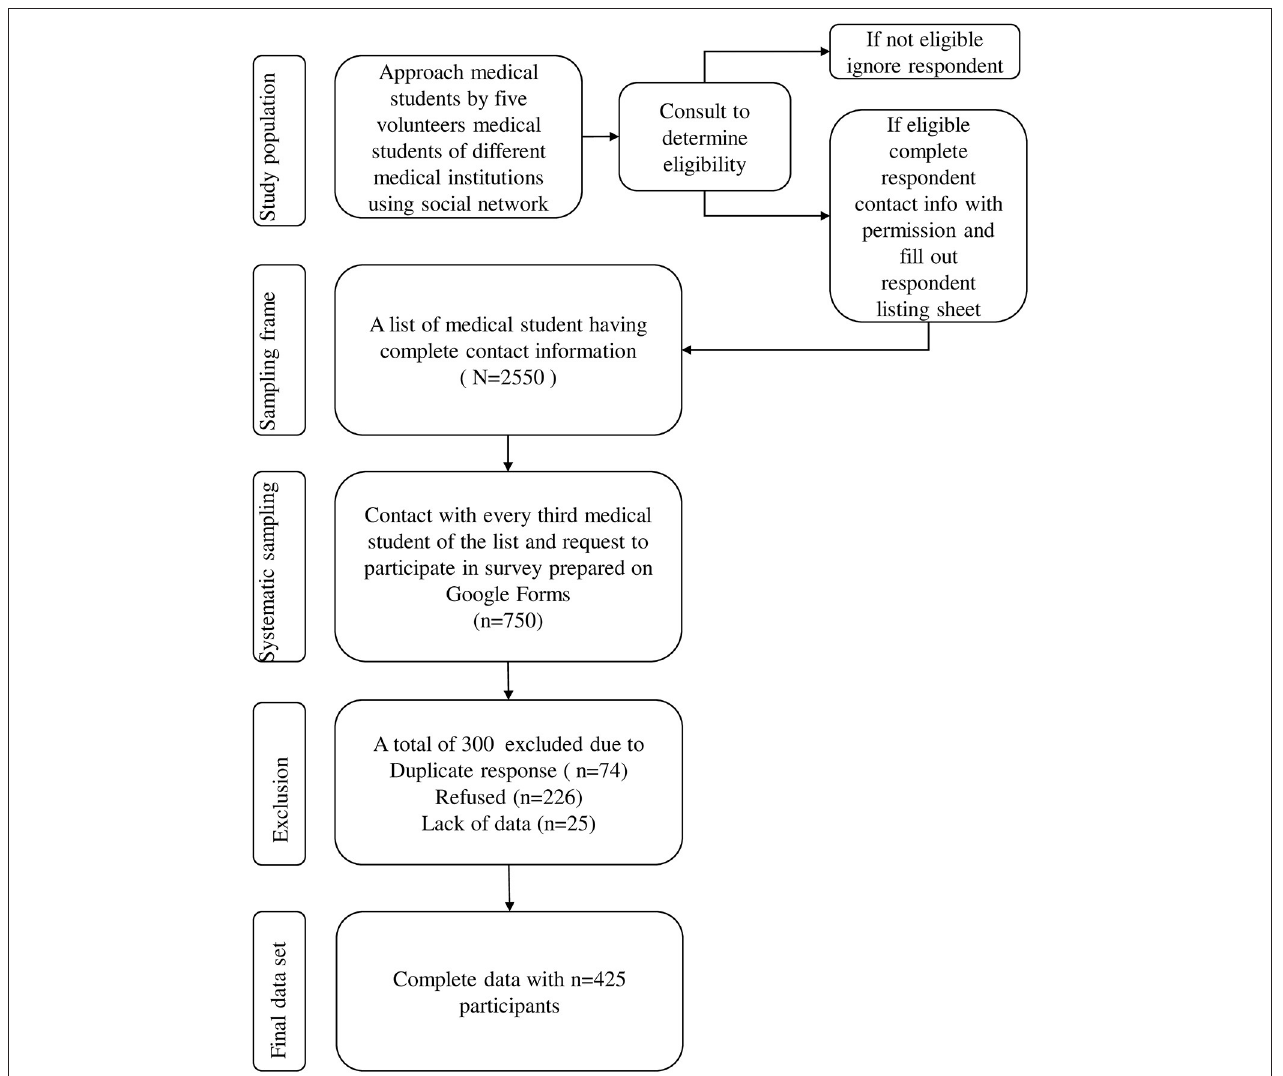
FIGURE 1 | Flow chart of sampling